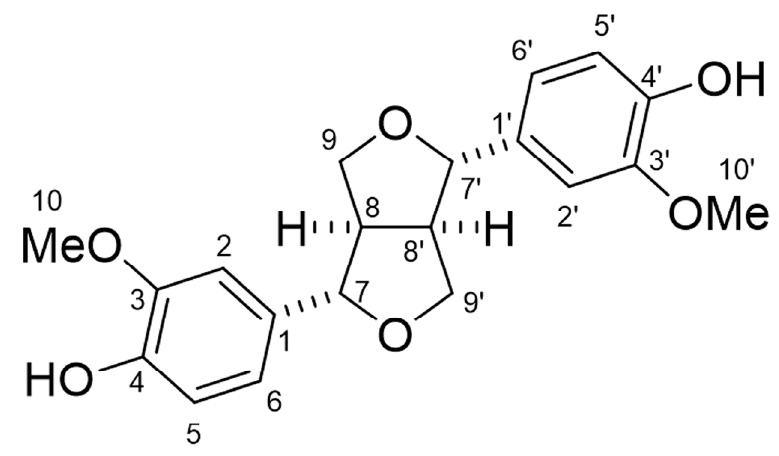
Figure 6. Chemical structure of